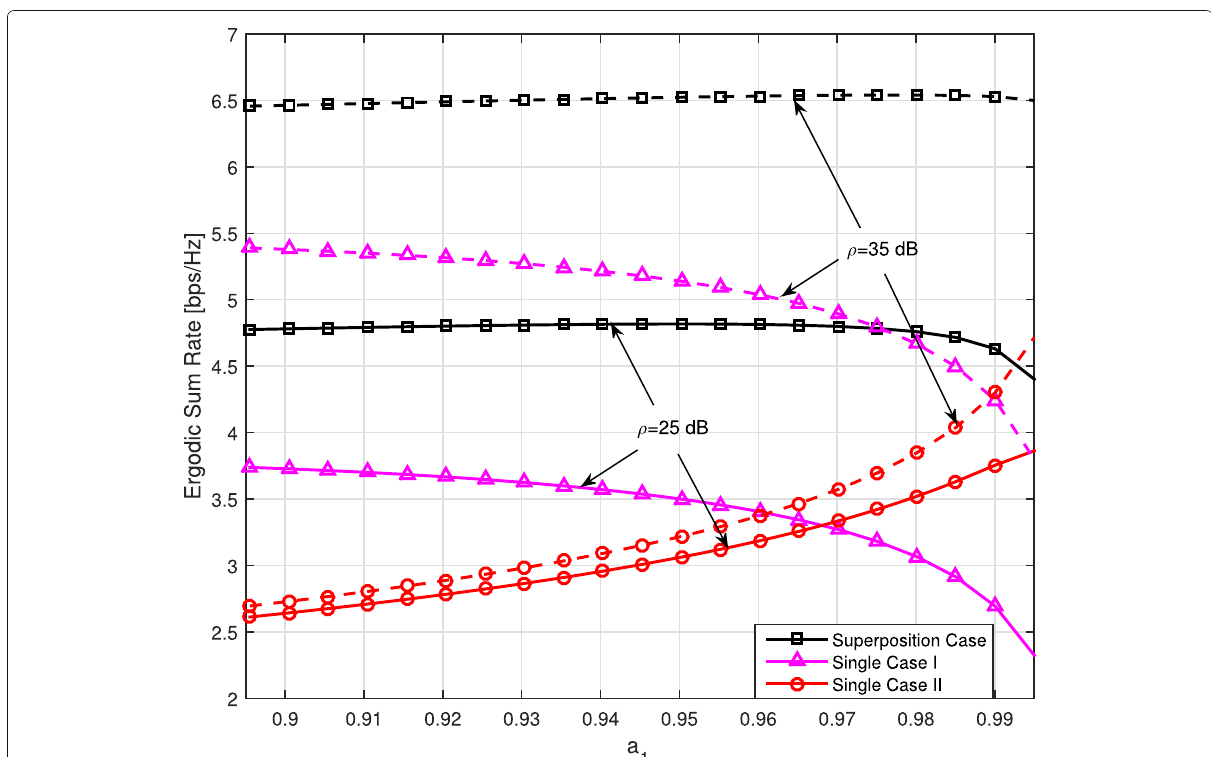
Fig. 5 The ergodic SRs achieved by our proposed and the conventional OMA schemes versus power allocation factors a 1 with fixed b 1 = 0.35 and c 1 = 0.7 for different transmit SNRs as ρ = { 25,35 }